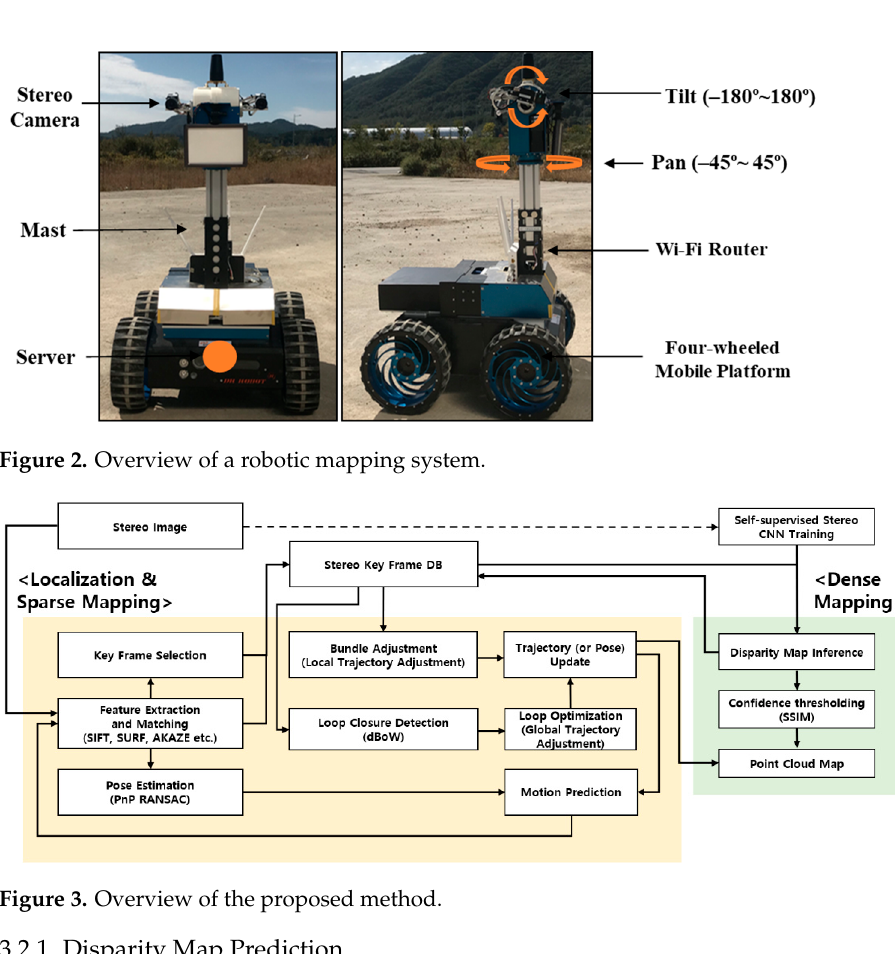
Figure 3. Overview of the proposed method.